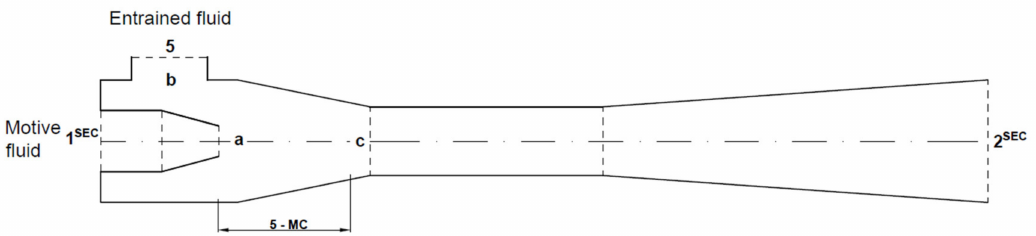
Figure 12. Spray ejector condenser 1 SEC : Nozzle inlet, a: Nozzle outlet, a–c: Mixing chamber, b: Suction chamber, c: Throat (part of Diffuser), c-2 SEC : Diffuser, 5 Inlet of entrained fluid, 5-MC: Entrained fluid in mixing